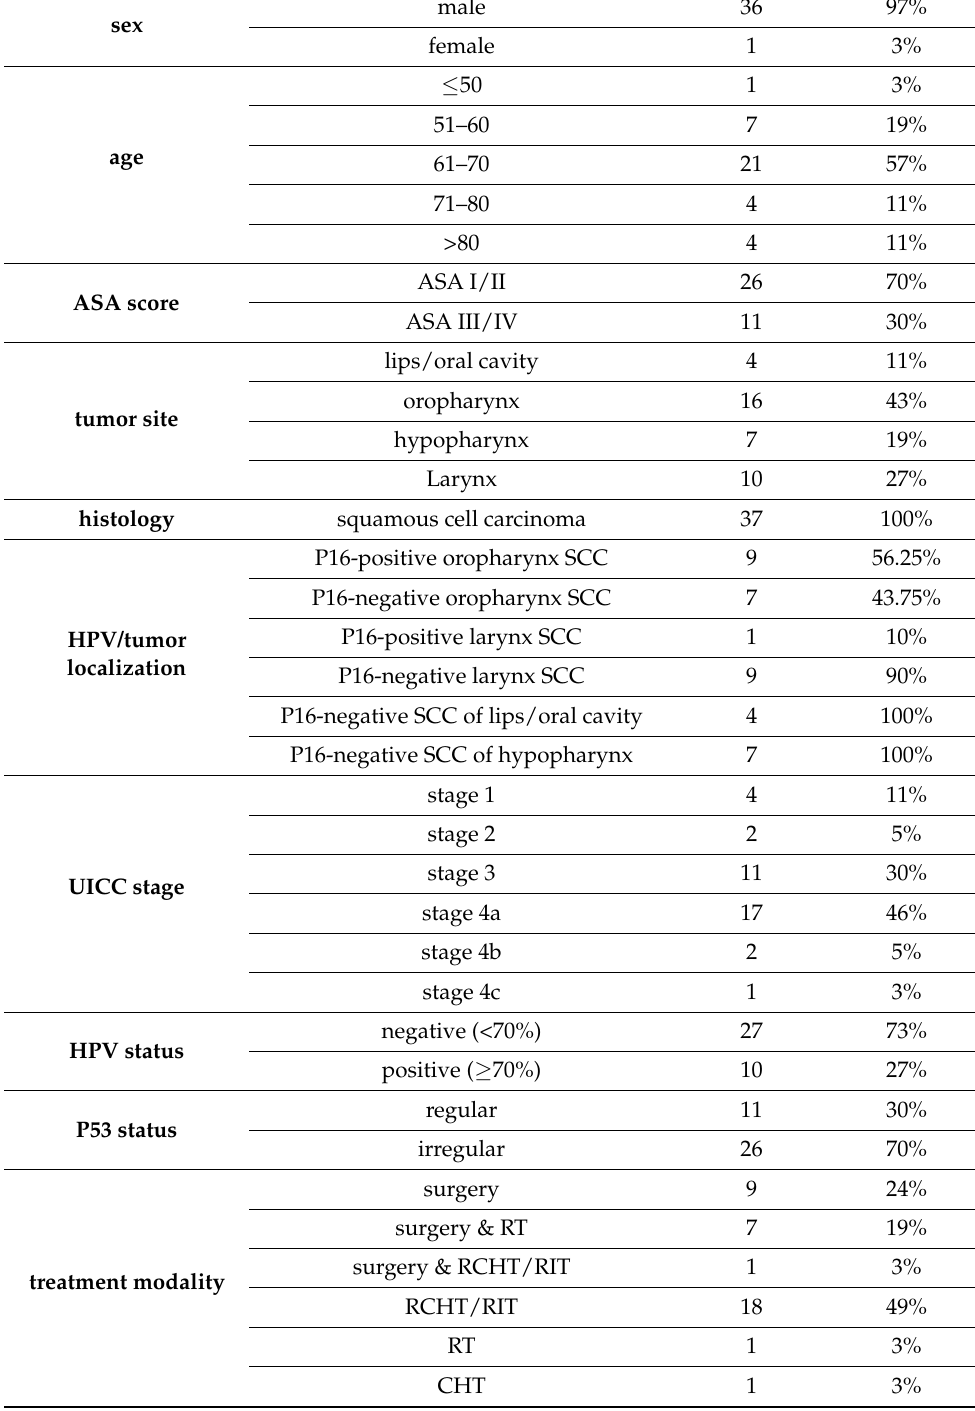
Table 1. Study population: Characteristics of the 37 patients with head and neck cancer, who gave their written informed consent to spend a histological sample for this study, and the RNA and cDNA samples were at sufficient quality for further